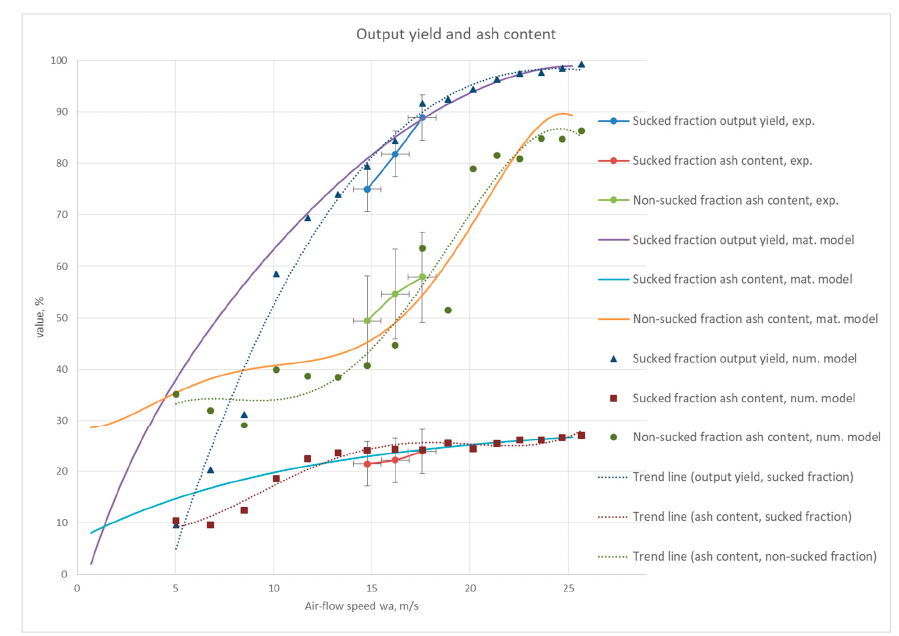
Figure A1. Comparison of values obtained experimentally and calculated using the developed models—output yield and ash content in relationship to air flow velocity; feed material no. 2 (0–20 mm).